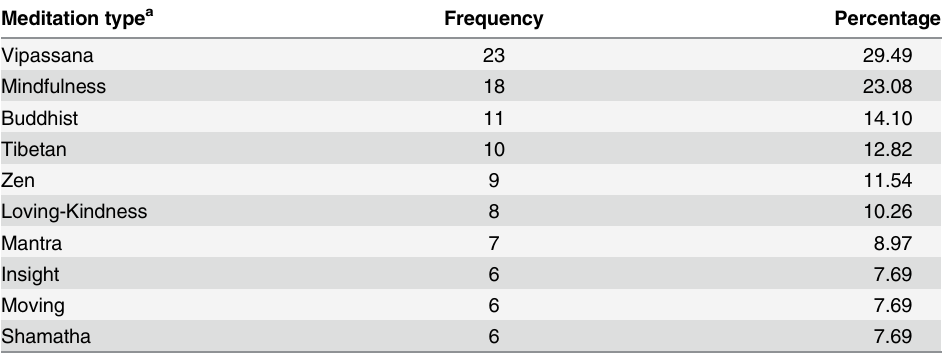
Table 4. Frequency of mediation practice type. Meditation type